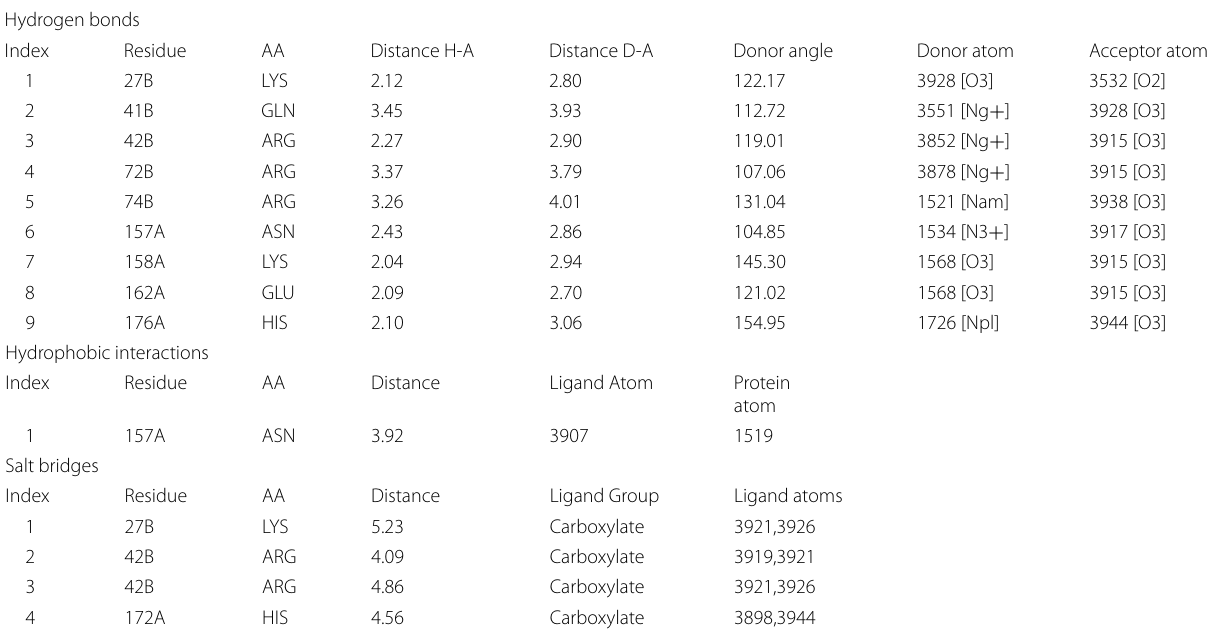
Table 3 Interactions of quercetin 3-O-arabinoside 7-O-rhamnoside with papain-like protease Hydrogen